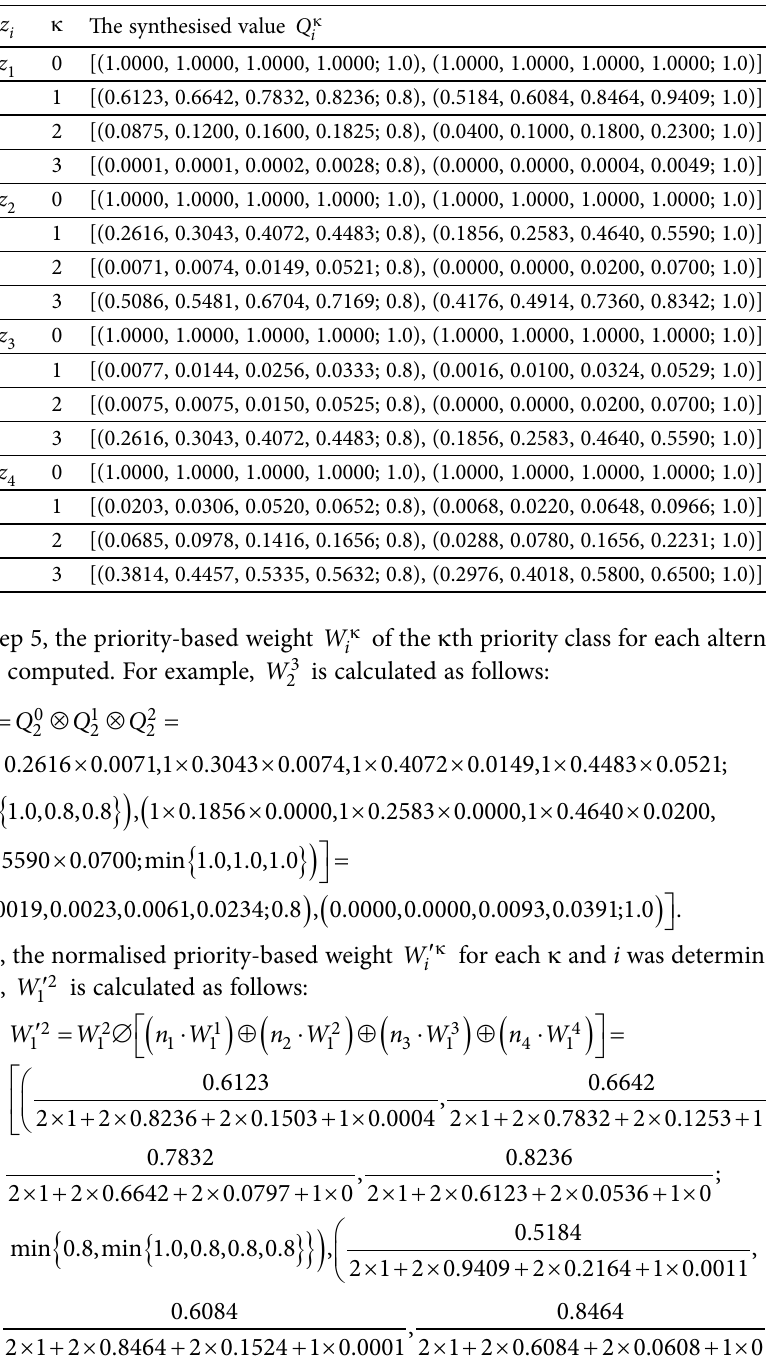
Table 4. Results for the synthesised